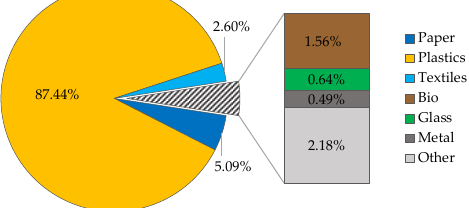
Figure 7. Morphology of the material used in this study.